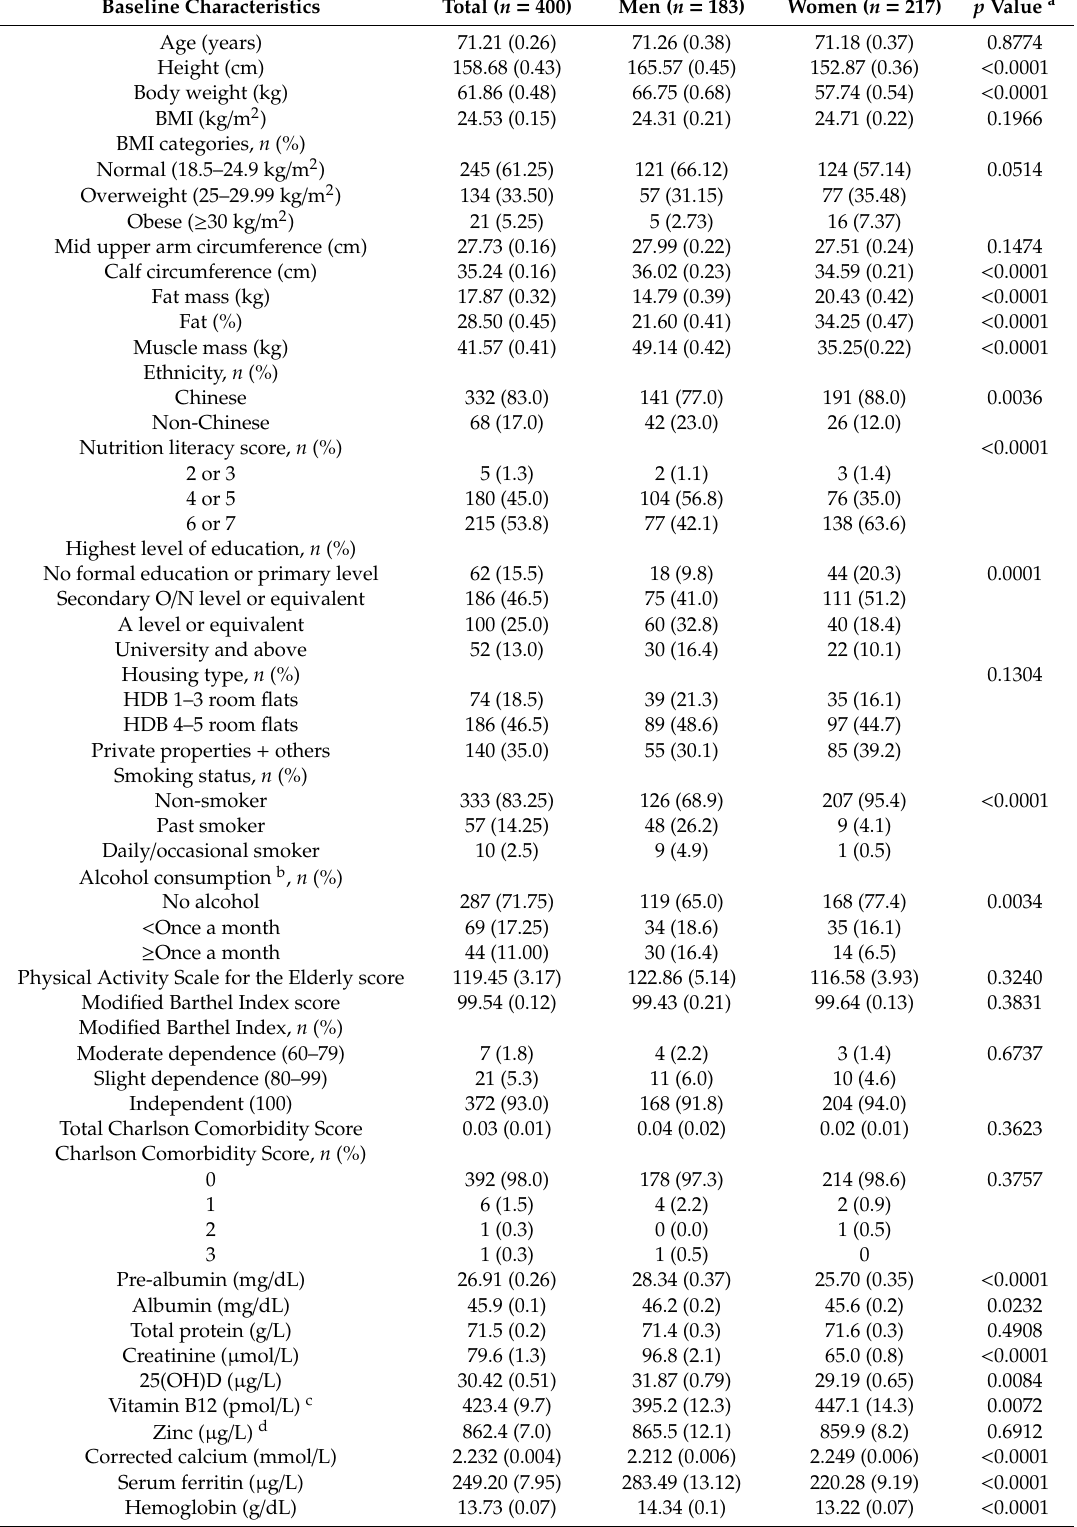
Table 1. Baseline characteristics of study